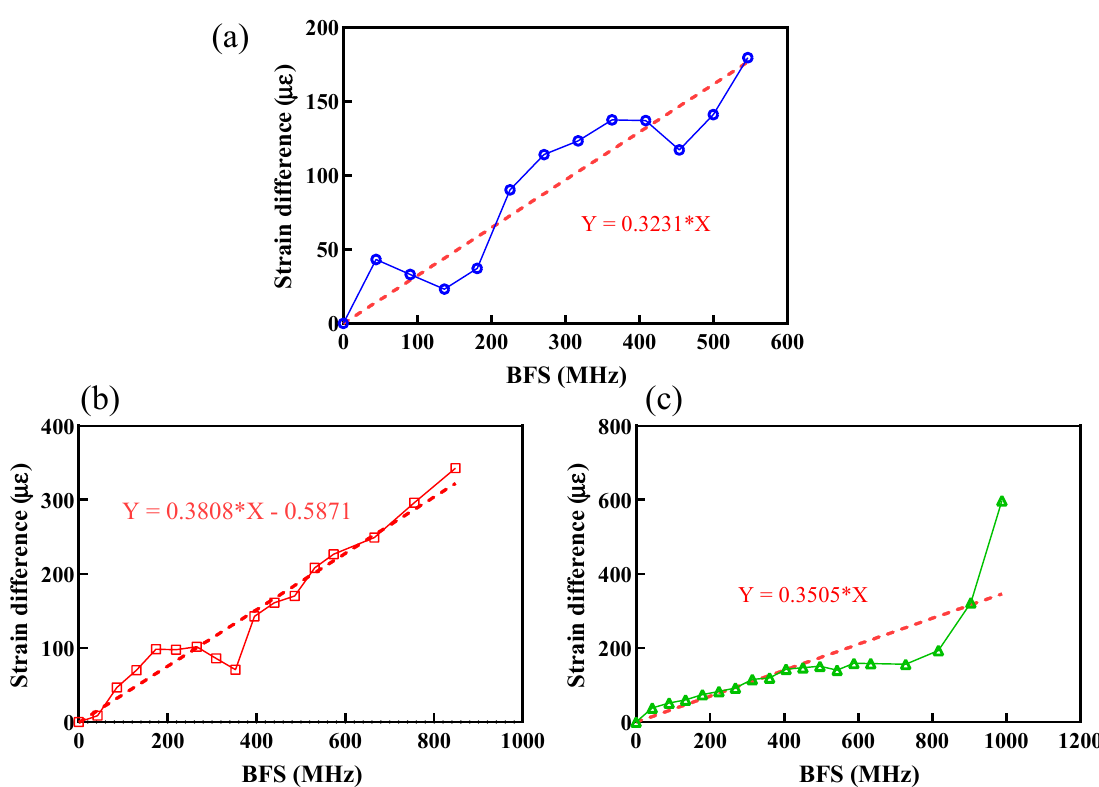
Figure 9. Difference in the fibre strain measured by the tensile load test method and the improved calibration method: ( a ) sensing cables A, ( b ) sensing cables B, and ( c ) sensing cables C.